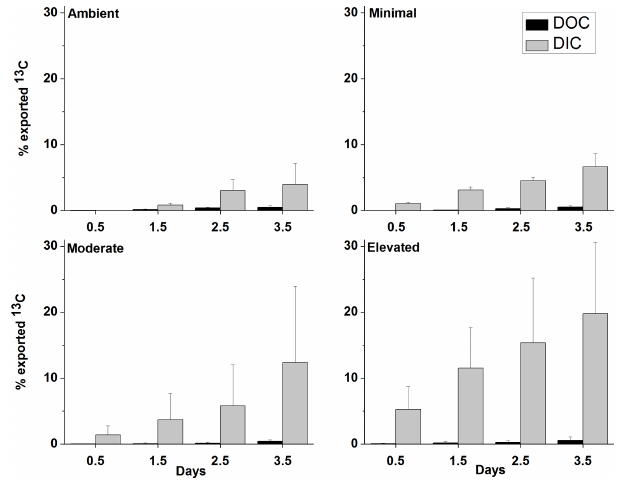
Figure 5. Effluxes of 13 C from the sediment as dissolved organic carbon (DOC) and dissolved inorganic carbon (DIC) as a percent- age of the total 13 C contained in sediment at 0–10cm depth at each sampling time (mean ±